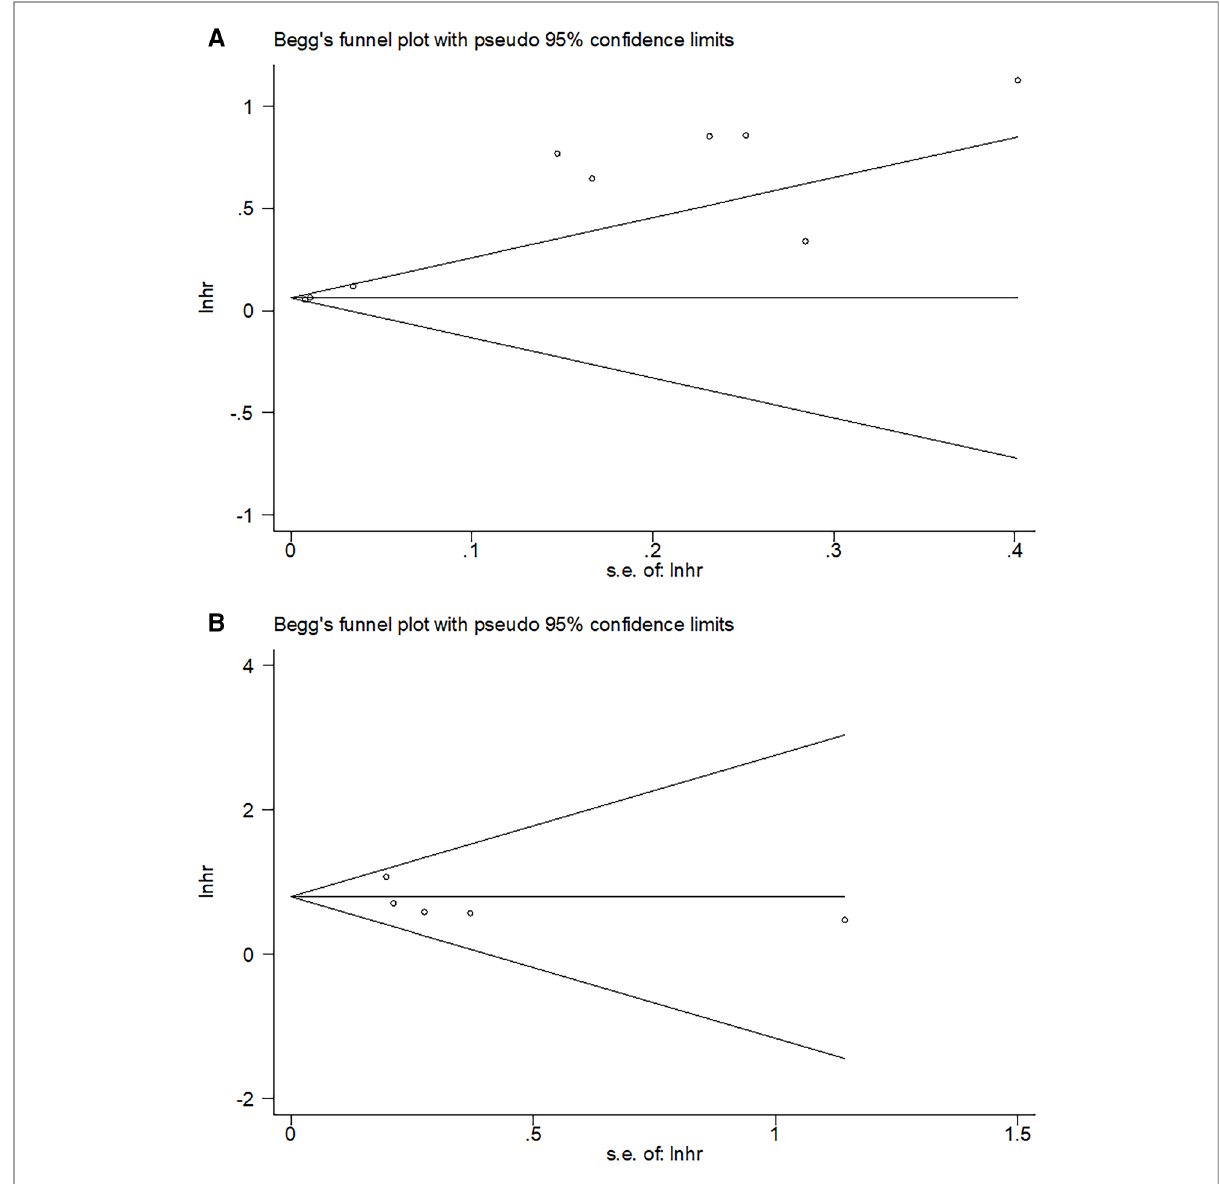
FIGURE 5 Begg ’ s funnel plot. ( A ) OS, P =0.602; ( B ) CSS, P